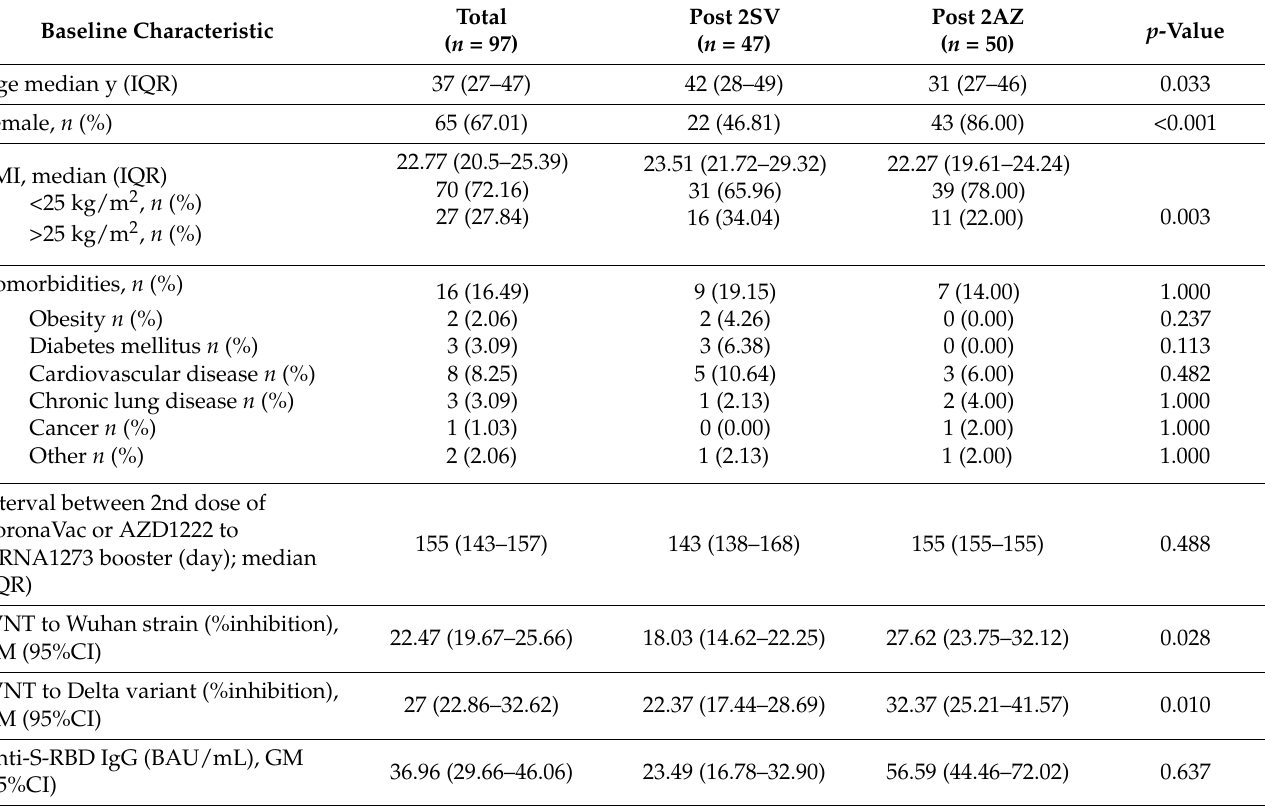
Table 1. Baseline characteristics of the study